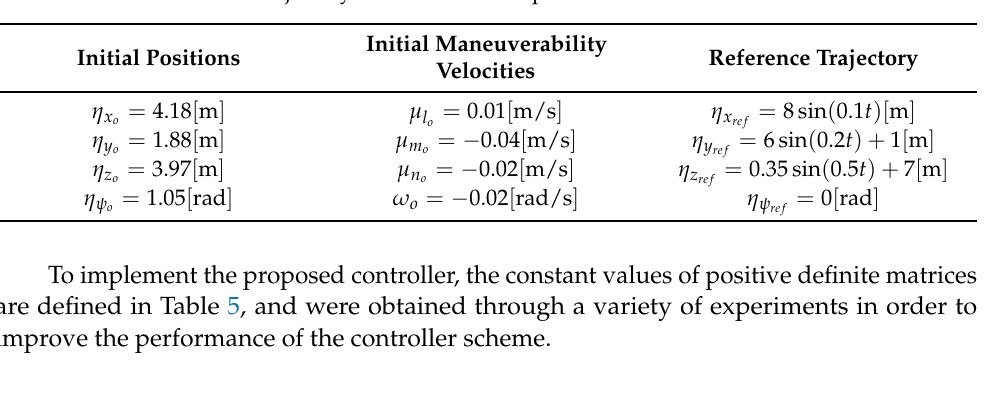
Table 4. Desired reference trajectory in a real-world